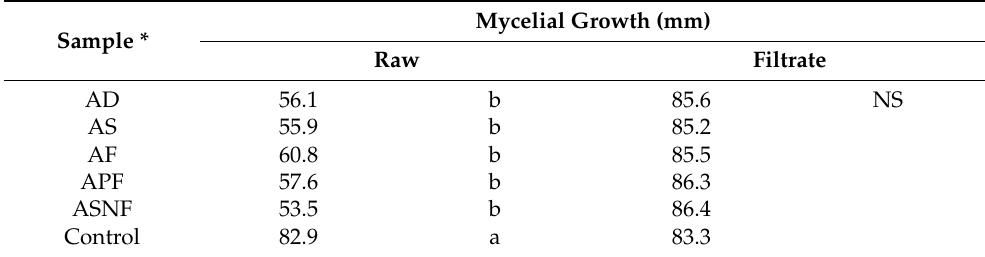
Table 2. Antifungal activity of raw and filtrate anaerobically digested slurries (ADSs) against Fos, indicated as mycelial growth by a co-culture